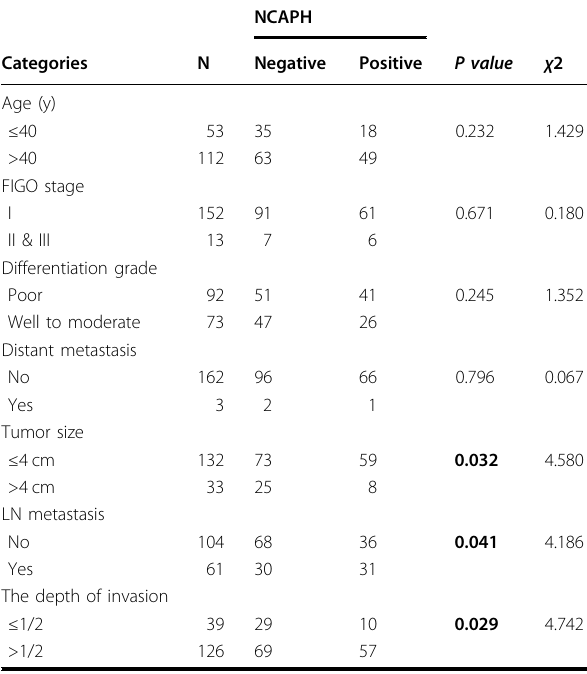
FIGO International Federation of Gynecology and Obstetrics, LN lymph node. p <0.05 was considered signi fi cant (indicated in bold).